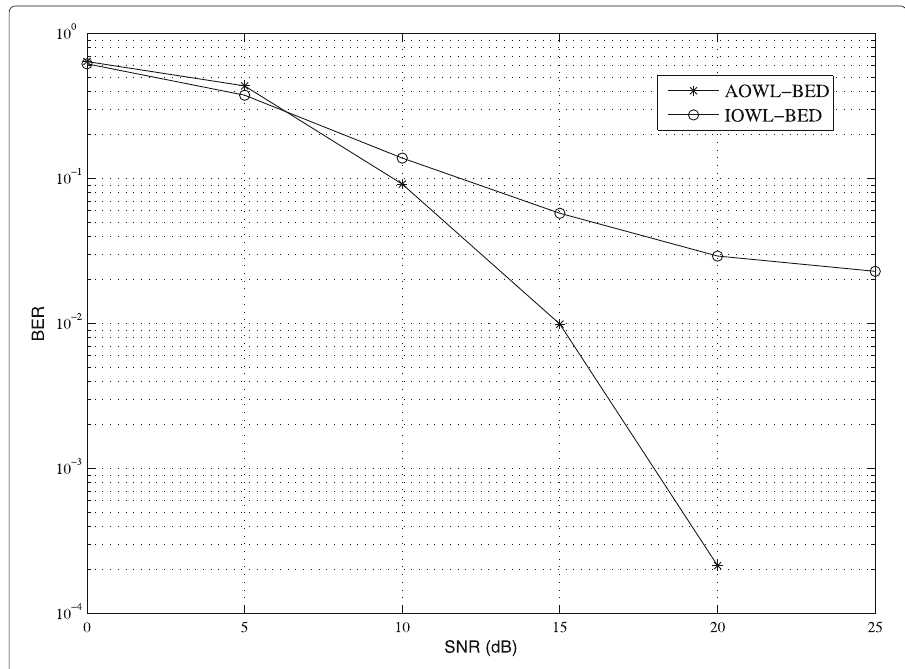
Fig. 4 BER performance comparison of VOWL-BED and IOWL-BED